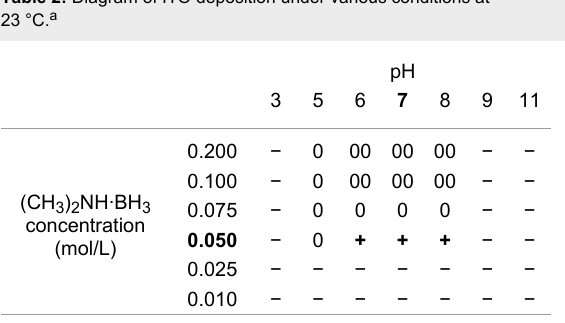
Table 2: Diagram of ITO deposition under various conditions at 23 °C. a